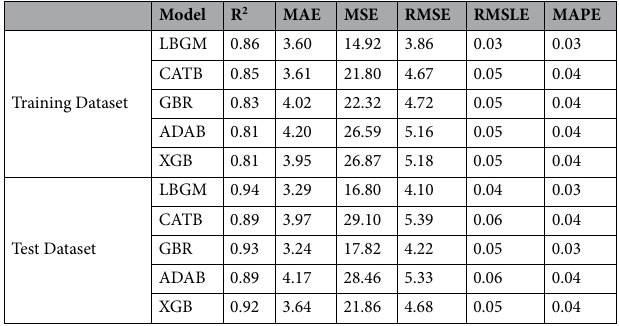
Table 3. Summary of initial